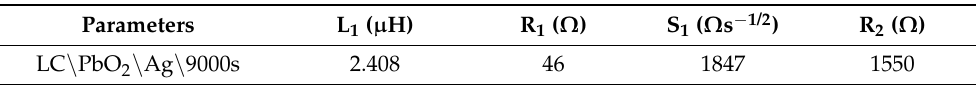
Table 4. Best-fitting parameters for sample LC/PbO2/Ag9000s according to the circuit shown in Figure